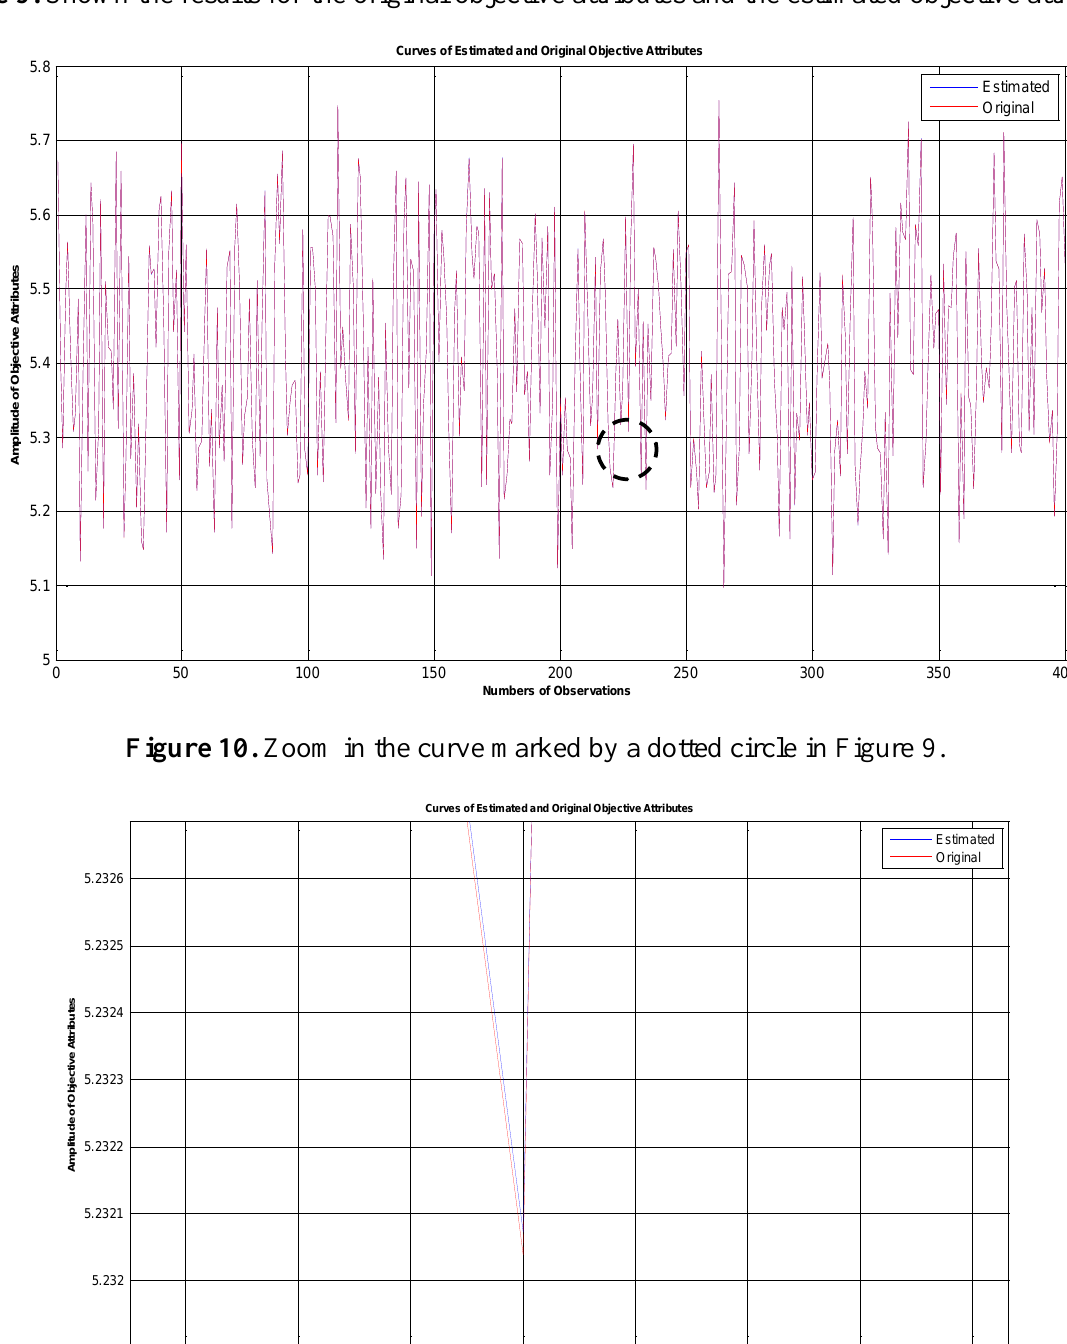
Figure 9. Shown the results for the original objective attributes and the estimated objective attributes.